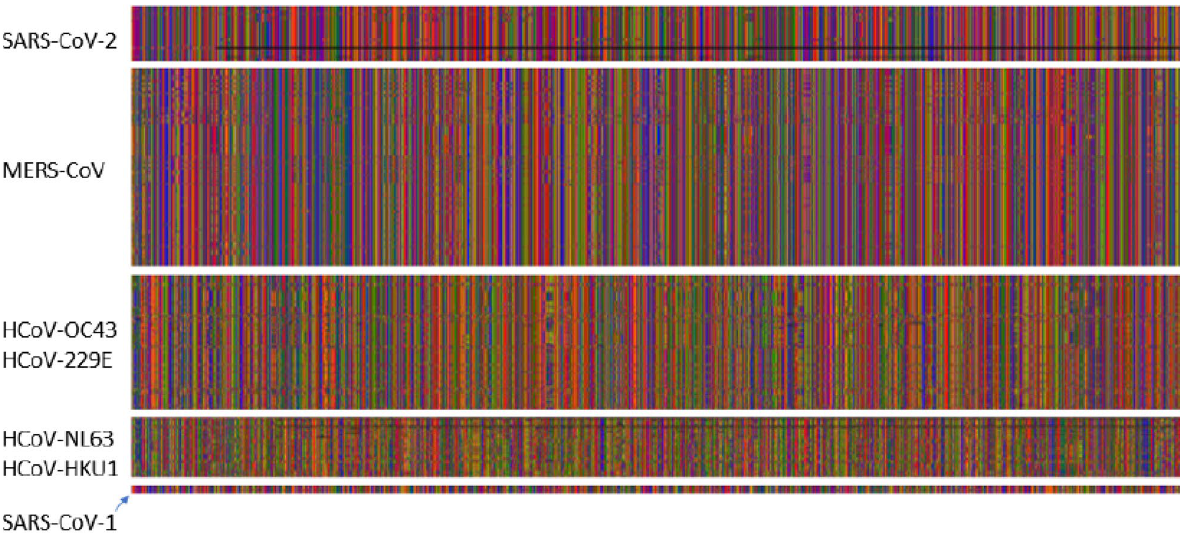
Figure 3. Input 3a, and output 3b of the methodology in colored pixels represent bases: G = green, C = blue, A = red, T = orange, missing = black. The data is separated by class SARS-CoV1: SARS-CoV, SARS-CoV P2, SARS-CoV HKU-39849 and SARS-CoV GDH-BJH01. For visualization purposes we do not show HCov-EMC and HCoV-4408, given the number of samples. From visual inspection, it is possible to notice the similarity of patterns between samples belonging to the same